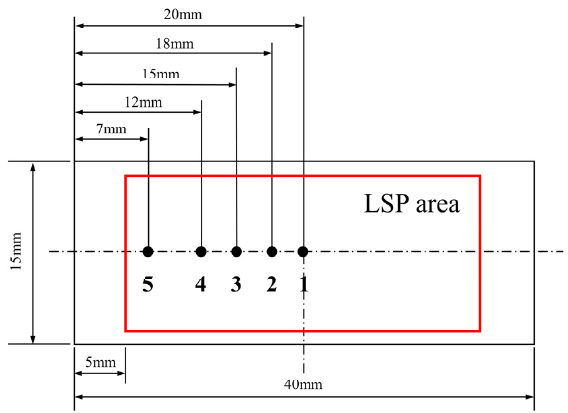
Figure 8. Distribution of residual stress test points.